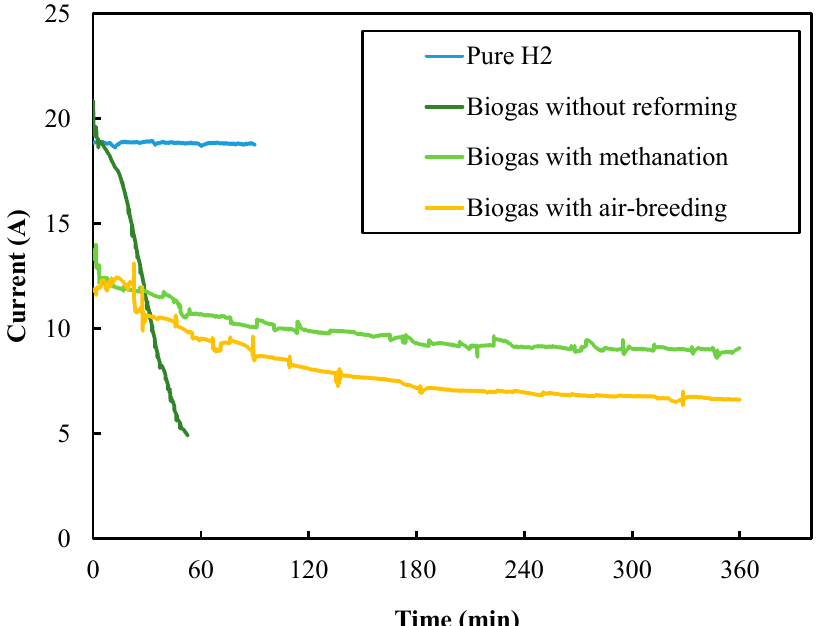
Figure 10. Comparison of the variation of the output current using pure H 2 , with and without the methanation reforming method.